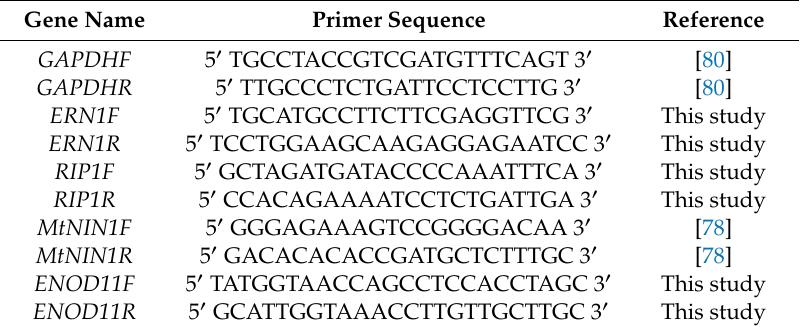
Table 1. The qRT-PCR primers used for assessing the expression of nodulation